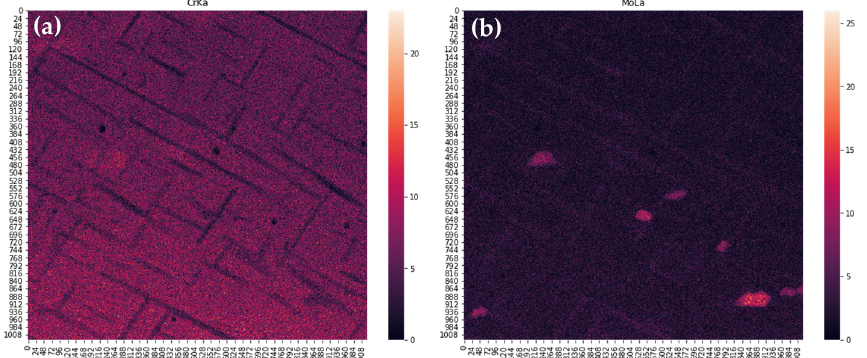
Figure 8. Unprocessed intensities summed over CrK α ( a ) and MoL α ( b ) peaks.